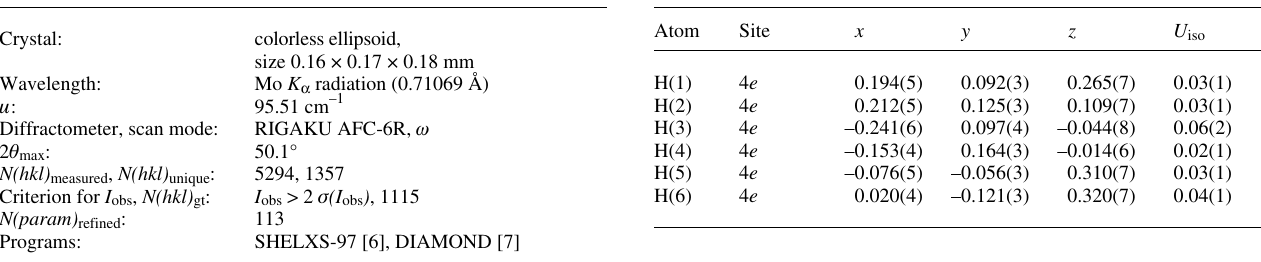
Table 1. Data collection and handling. Table 2. Atomic coordinates and displacement parameters (in Å 2 )